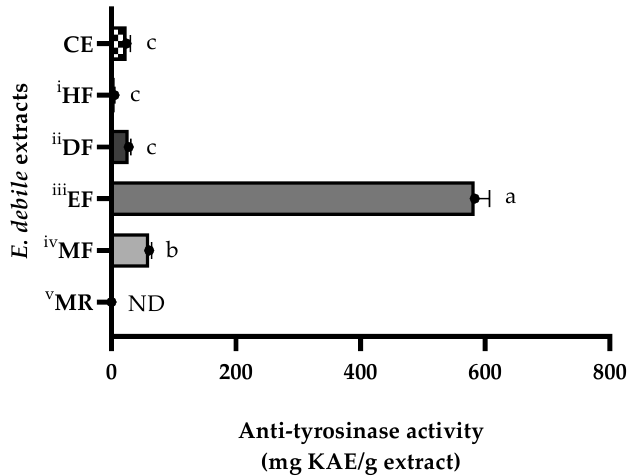
Figure 7. Anti-tyrosinase activities of E. debile extracts. i–v Successive partition of crude extract (CE) (10.45 ± 1.20 g) into hexane fraction (HF), dichloromethane fraction (DF), ethyl acetate fraction (EF), methanol fraction (MF), and methanol insoluble residue (MR). All data are presented as mean ± SD of triplicates. Anti-tyrosinase activities were expressed as KAE (kojic acid equivalents). ND indicates not detected. Letters (a, b, and c) indicate significant differences of means between the groups based on Tukey’s HSD one-way ANOVA ( p -value < 0.05). Table 3. Anti-tyrosinase and anti- 5α -reductase activities of E. debile extracts.